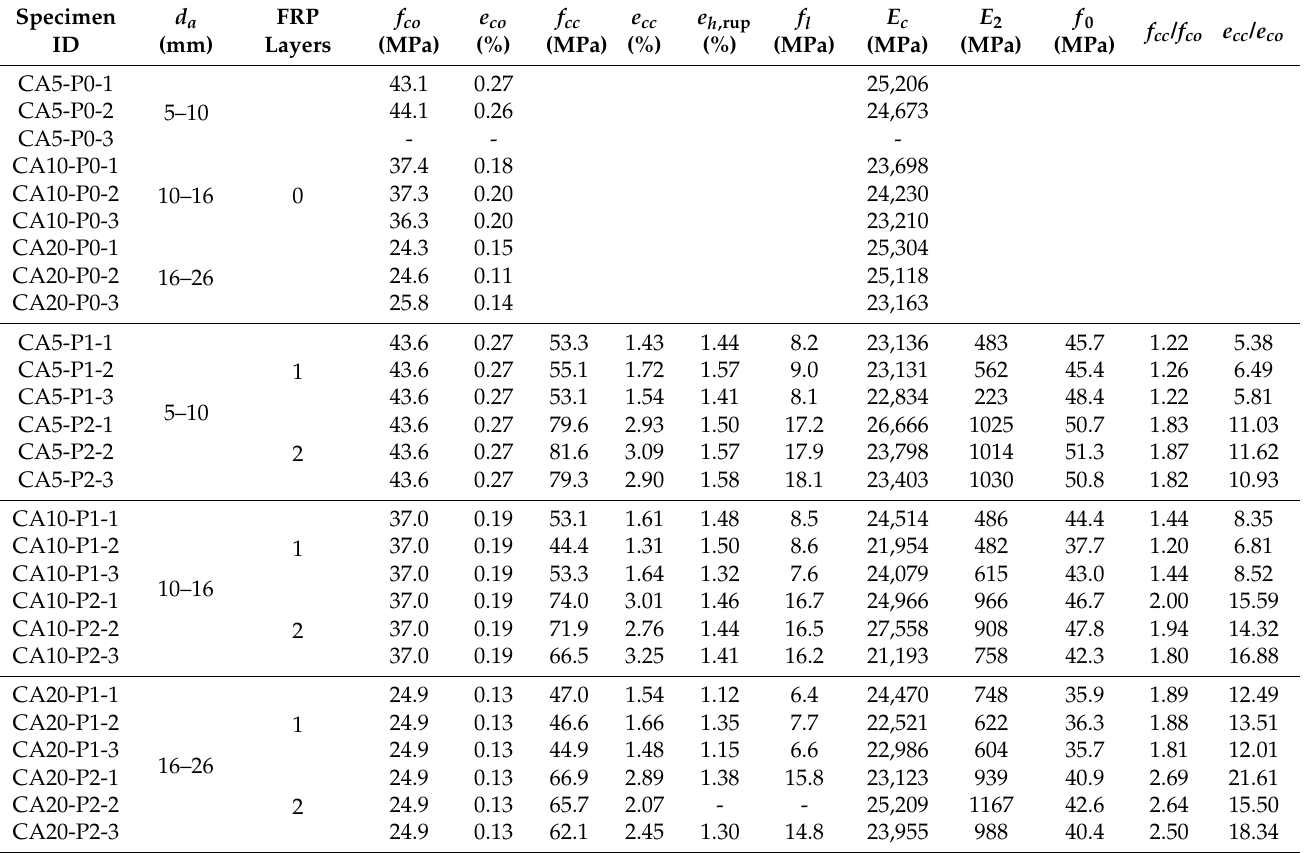
Table 1. Detailed information of all tested column